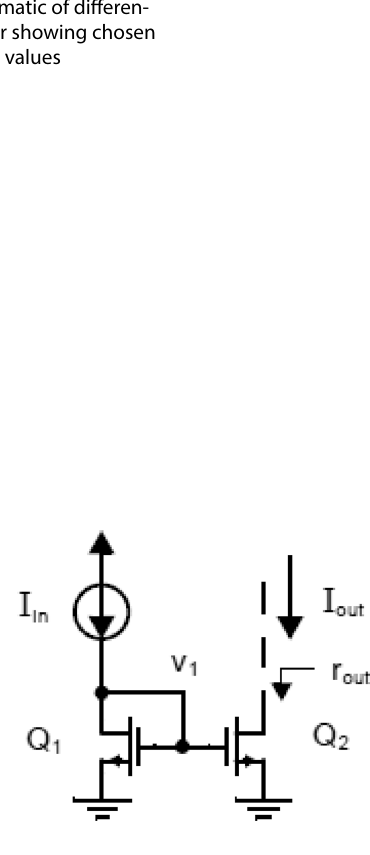
Fig. 9 Widlar current mirror [3]